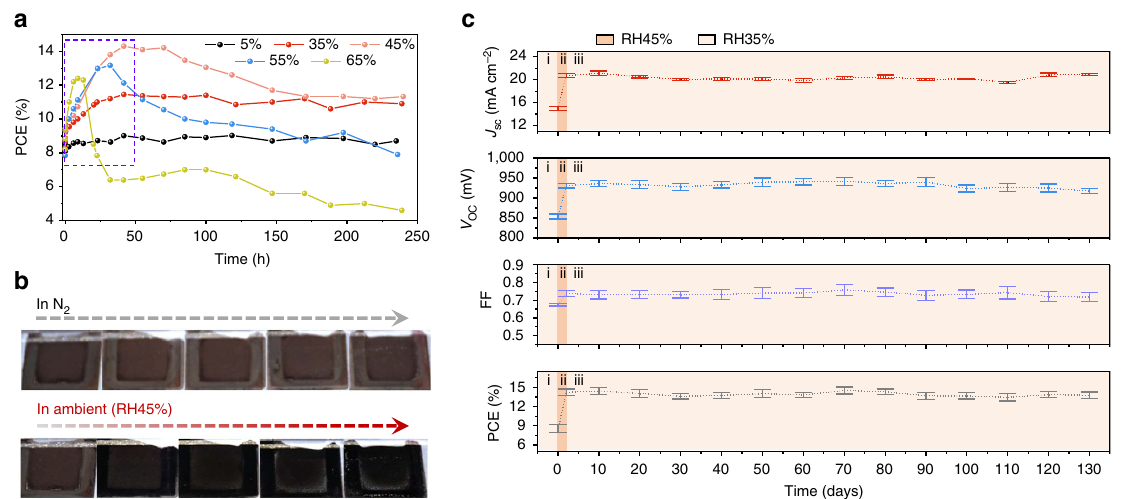
Figure 2 | Comparison of the device performance under ambient conditions. ( a ) PCE variations of as-annealed devices stored under ambient conditions with RH5–65%. The significant improvement in efficiency is marked with a purple rectangle. ( b ) Digital images (from the glass side) of the as-annealed devices stored in inert (N 2 ) and ambient atmosphere (RH45%). ( c ) Variations of J SC , V OC , FFand PCE of devices upon fabricating and ageing under ambient condition without encapsulation ((i) device fabrication except the ambient exposure, RH35%; (ii) ambient exposure, RH45%; (iii) long-term storage, RH35%). Error bars represent s.d. calculated from four devices prepared at the same